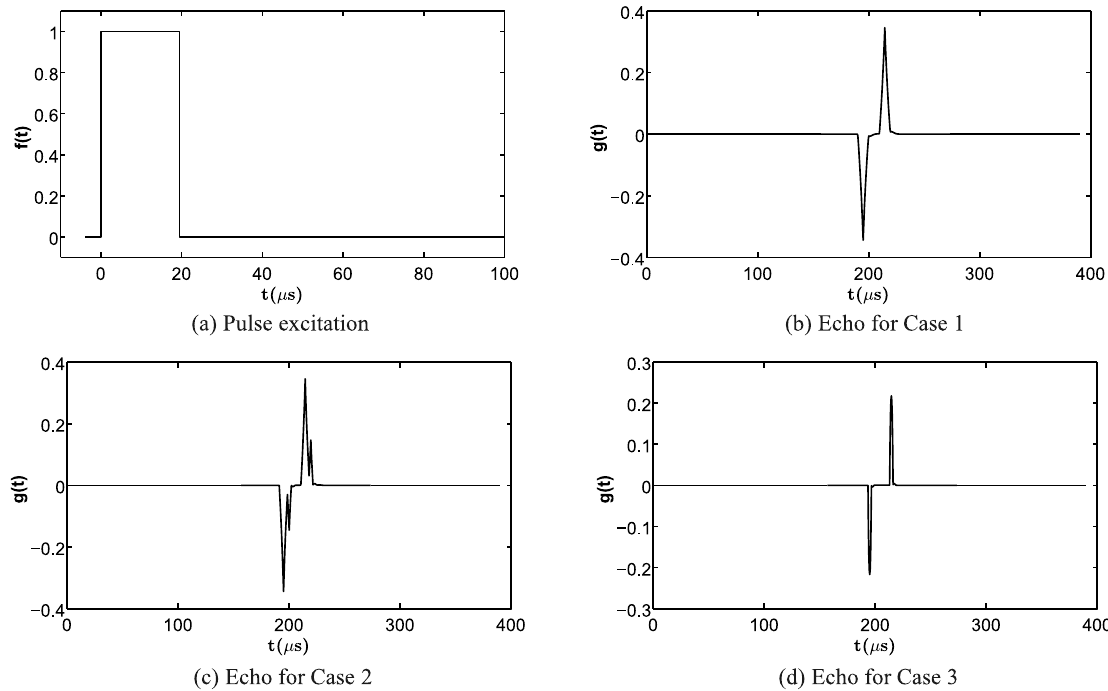
Fig. 3. Noiseless pulse and echo signals for Cases 1, 2 and